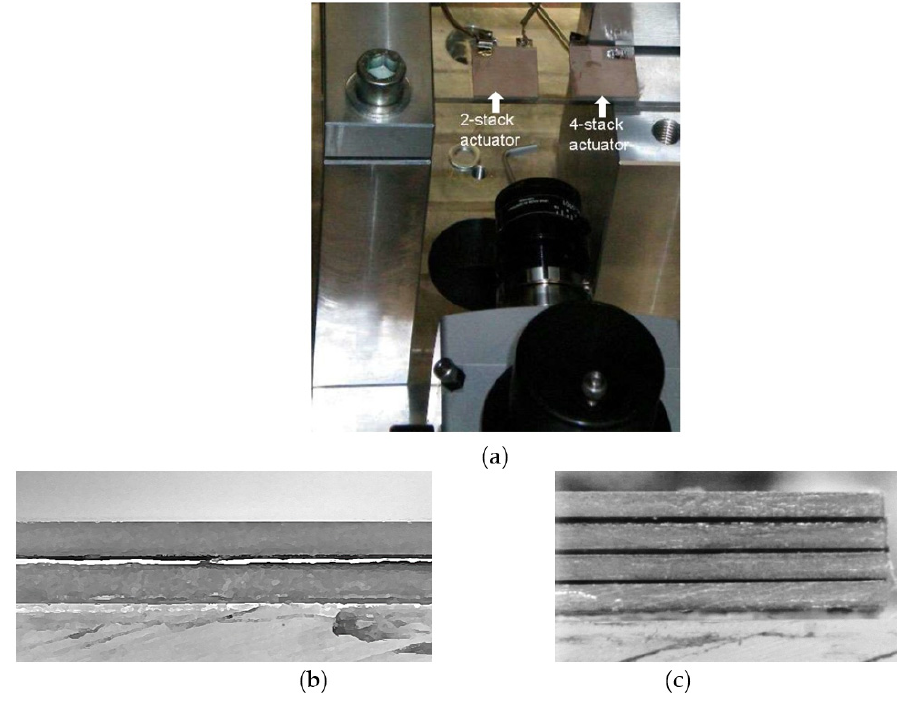
Figure 3. ( a ) Experimental assembly with two-stack and four-stack actuators, and cross-sectional views of ( b ) two-stack and ( c ) four-stack piezoceramic benchmarks.